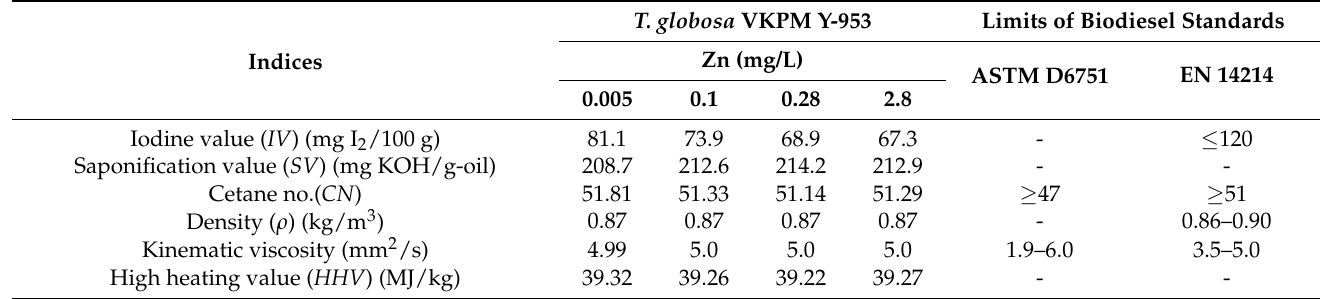
Table 3. Biodiesel properties of T. globosa VKPM Y-953